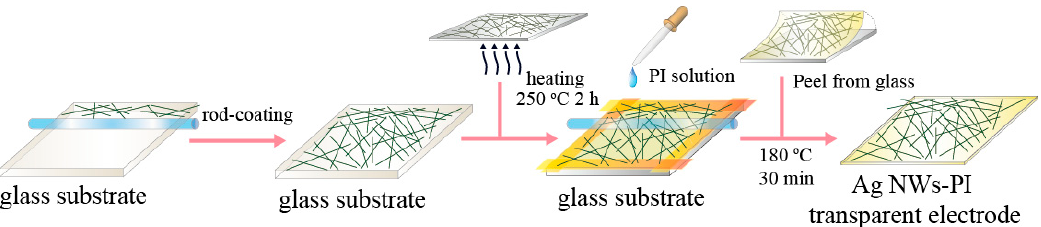
Figure 1. Schematic illustration of the fabrication process of Ag NW-PI (Ag nanowire-polyimide) transparent conductive film.